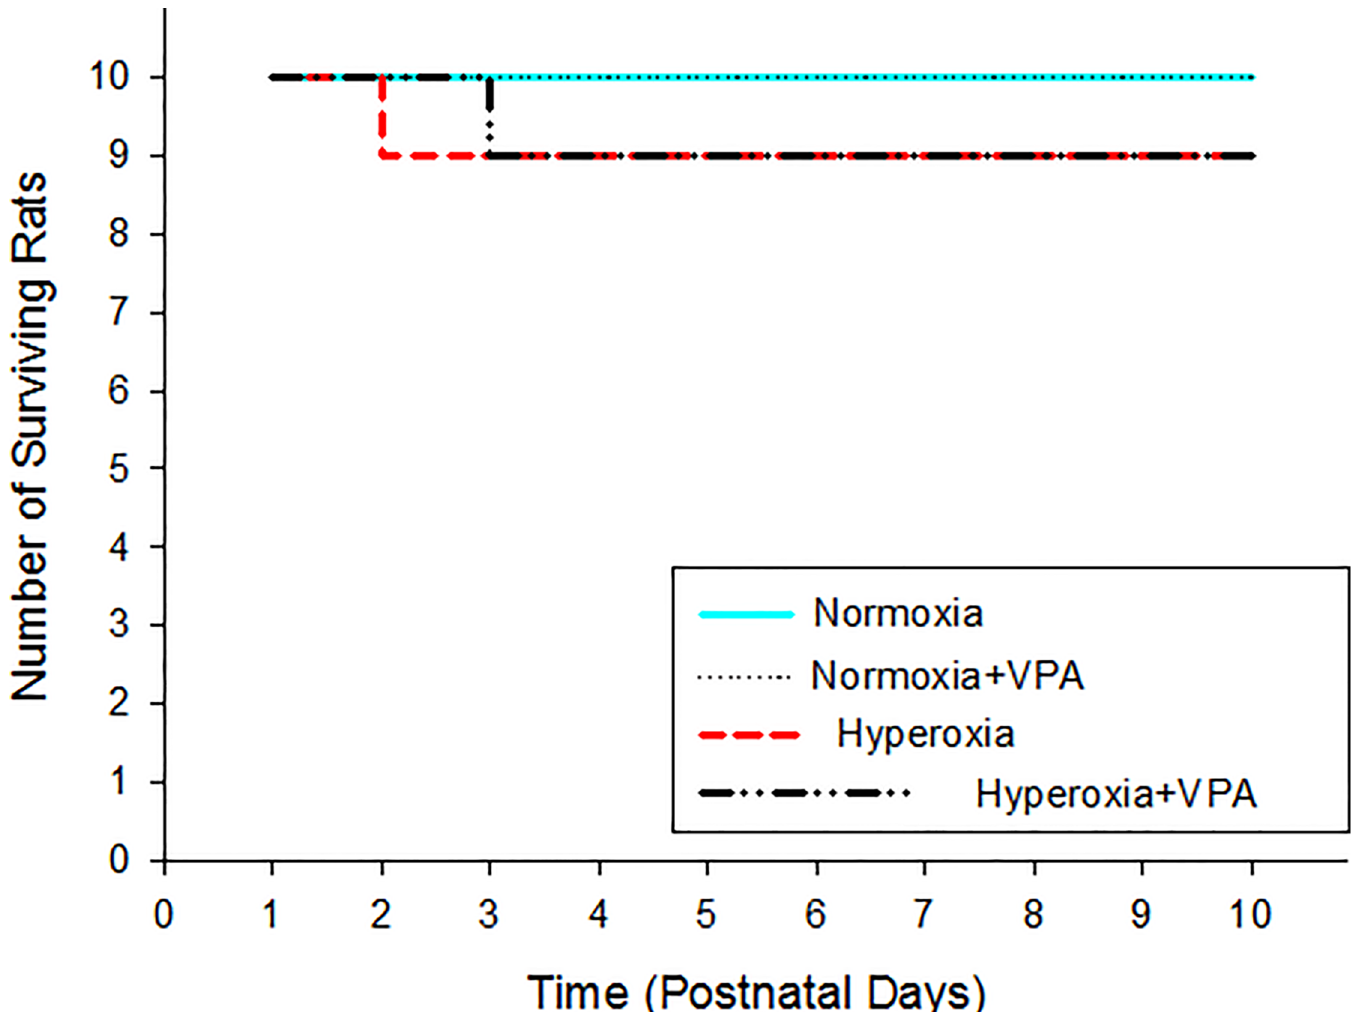
Fig 1. Number of surviving rat pups in experimental